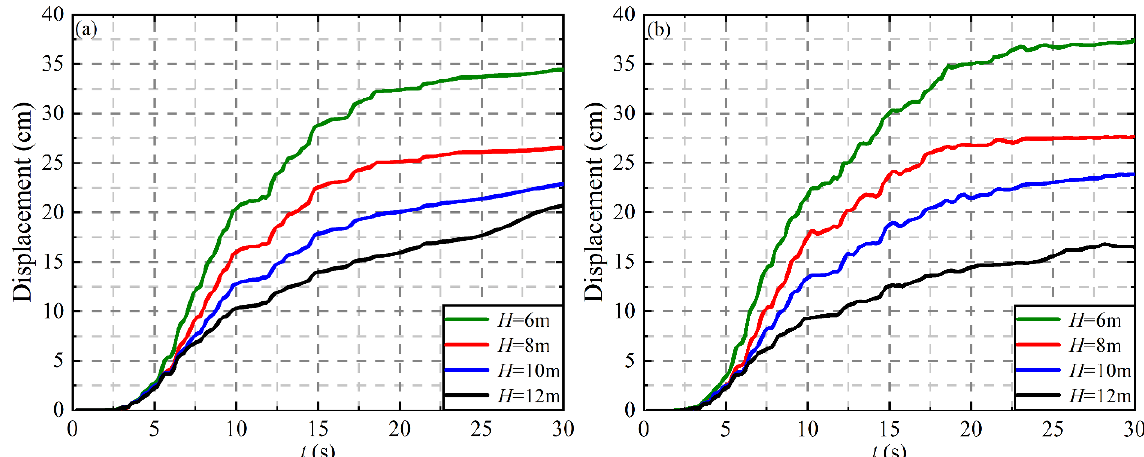
Figure 12. Comparison between the stochastic and deterministic analyses of the time history of tun- nel uplift displacement: ( a ) random cases; ( b ) deterministic cases. tunnel uplift displacement: ( a ) random cases; ( b ) deterministic